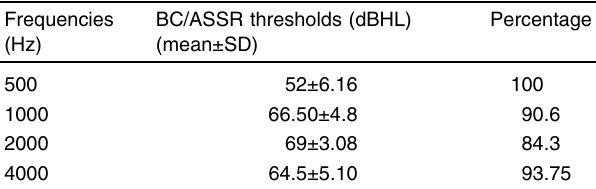
Table 4 BC/ASSR thresholds and detectability in children with severe-to-profound